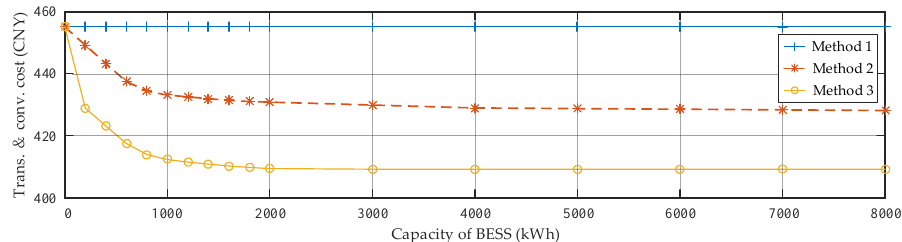
Figure 8. Results of transformer and converter cost reduction of three scenarios with BESS